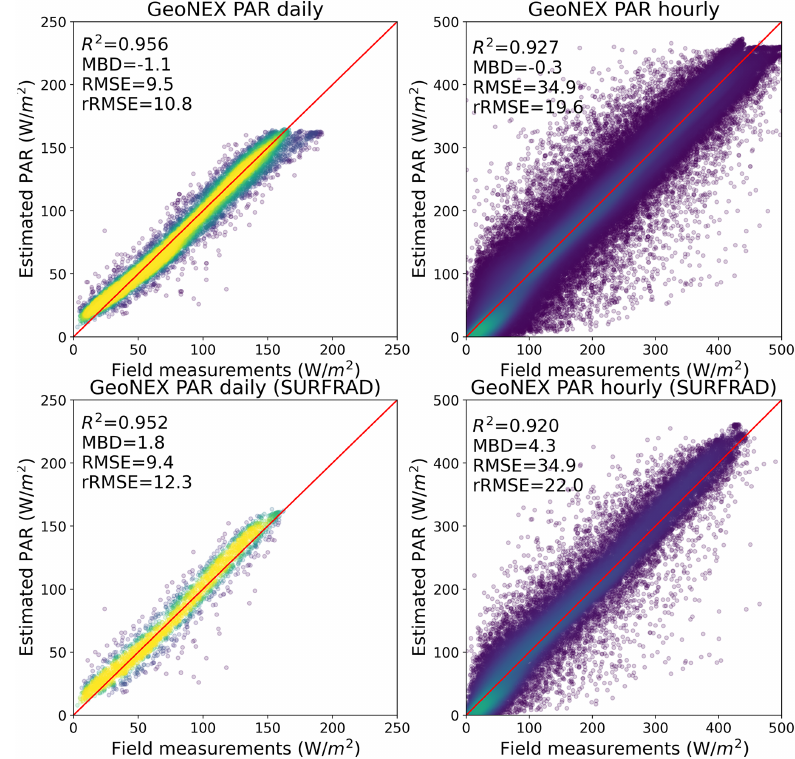
Figure 6. Scatter plots of the estimated and observed daily and hourly PAR values for ABI